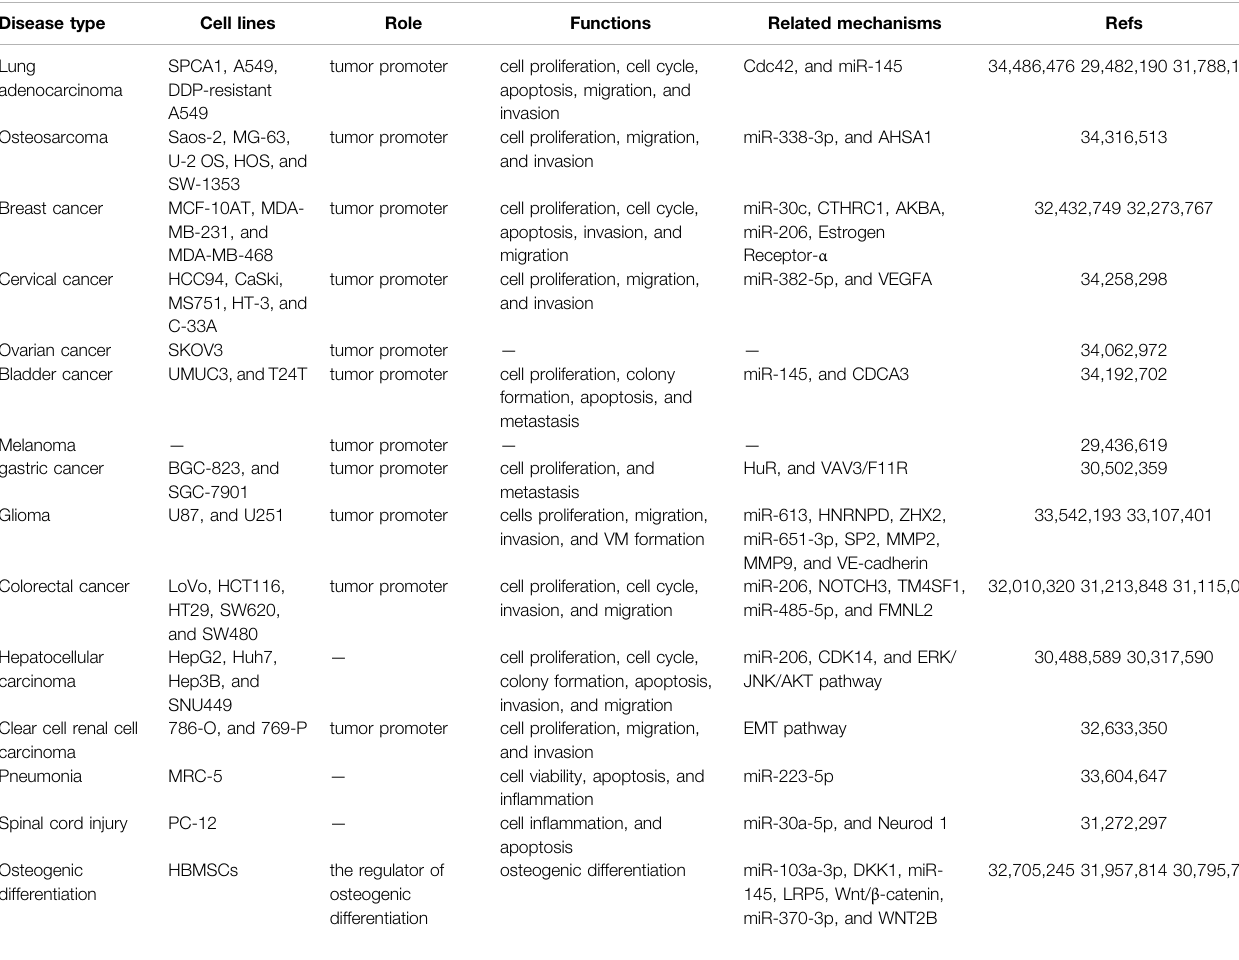
TABLE 2 | Functions and mechanisms of LINC00707 in diverse